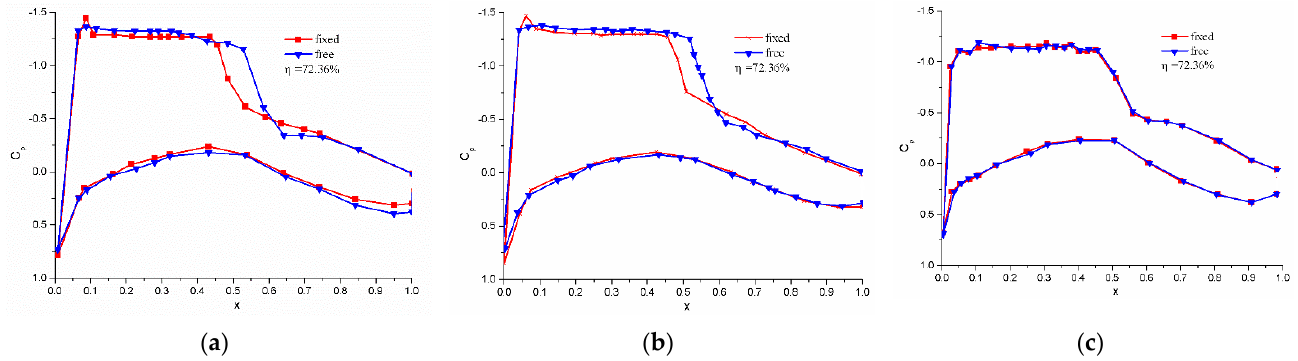
Figure 10. Pressure distributions with and without transition band under different Reynolds numbers (M = 0.76, α = 4°, η = 72.36%): ( a ) Re = 3.3 × 10 6 ; ( b ) Re = 6.6 × 10 6 ; ( c ) Re = 15 × 10 6 .